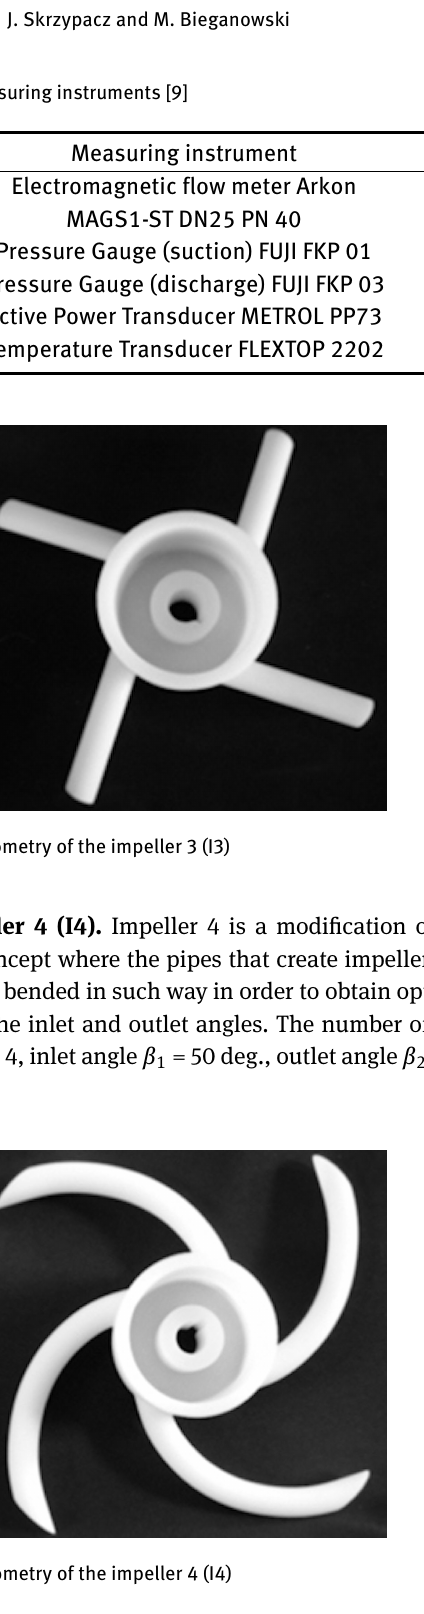
Figure 4: Geometry of the impeller 4